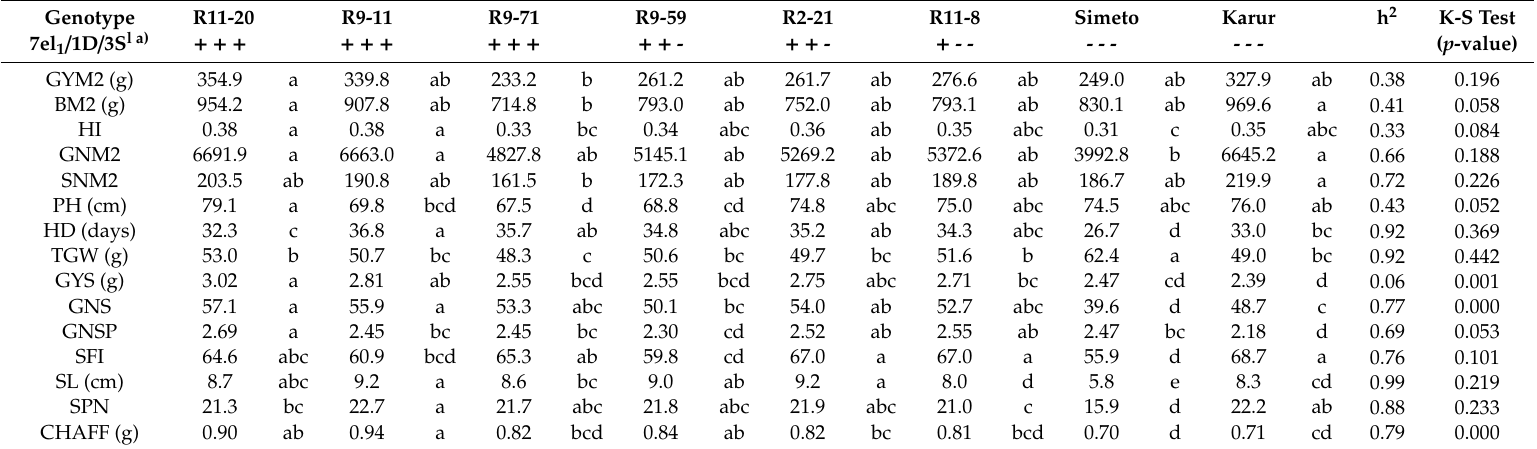
Table 4. Mean values of yield-related traits and narrow-sense heritability of the analysed genotypes across 2015 and 2016